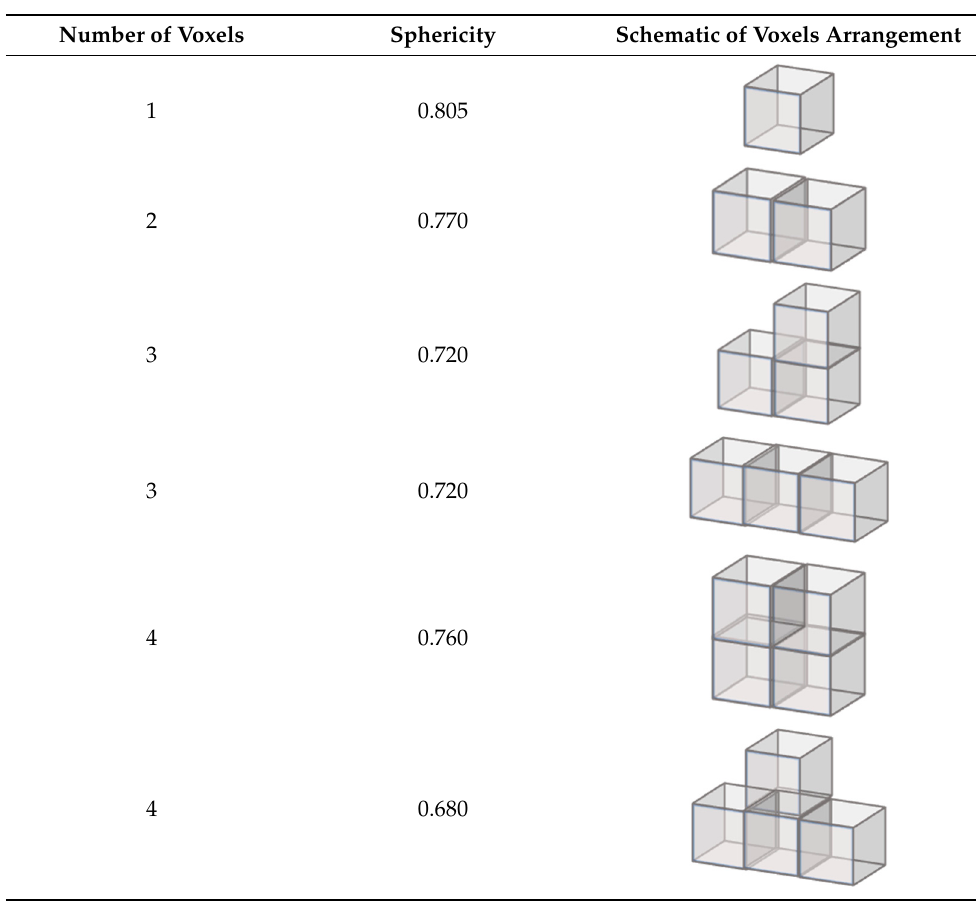
Table 4. Schematic of the voxels’ arrangement for several void sphericity.